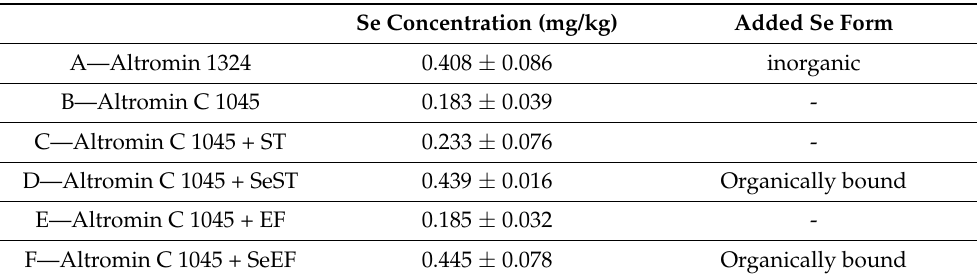
Table 1. Selenium concentrations and its forms in the experimental groups; data are presented as the mean ± expanded uncertainty with coverage factor k =